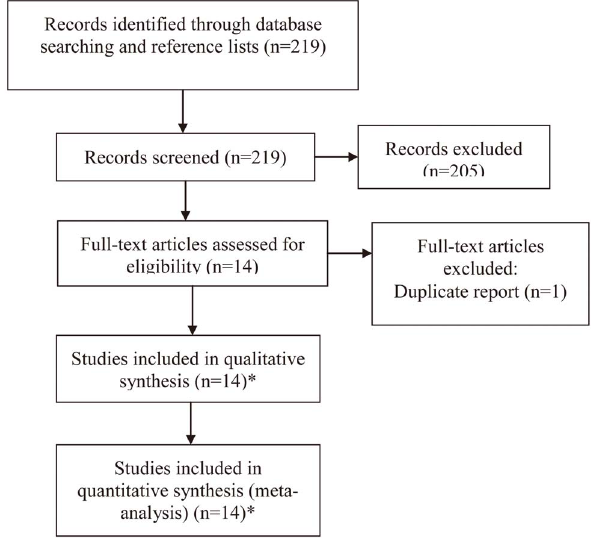
Figure 1. Flow Diagram of study selection. *the two popula- tions in Chang JS’s study were treated as 2 separate studies.